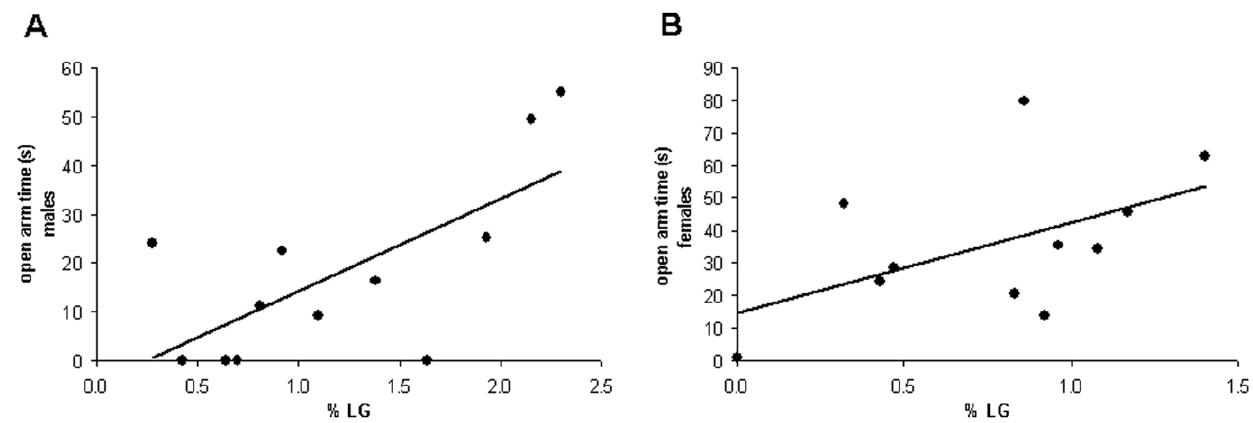
Figure 1. Elevated Plus Maze. (A) In ten-week-old male offspring a positive correlation emerged between %LG and open arm time on the Elevated Plus Maze (n=12, r=0.690, p=0.013), indicating reduced anxiety in animals with higher LG scores. (B) Similarly, in 8-week-old females, there was a positive trend between these parameters (n=11, r=0.511, p=0.108).